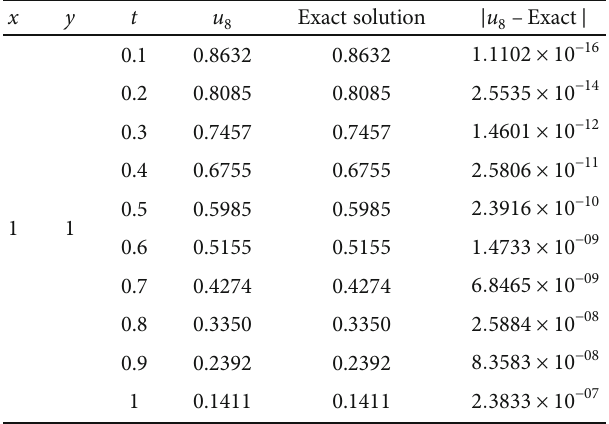
Table 4: Eighth-order approximate numerical solution by RDTM of Example 3 for di ff erent values of t and comparison with the exact